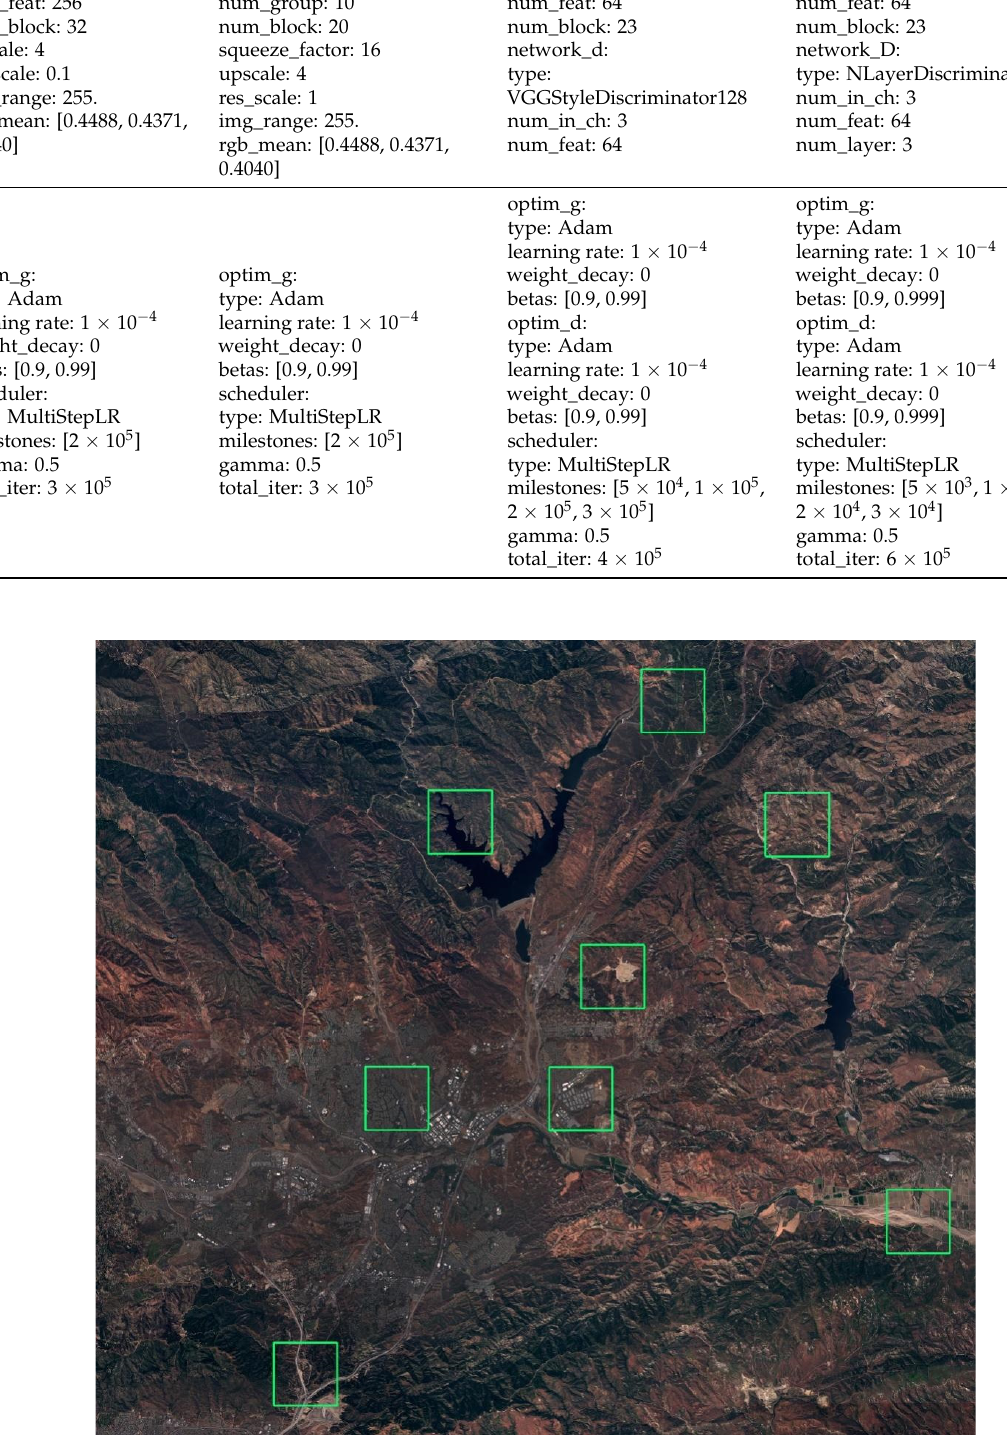
Figure 10. Ground map corresponding to sub-dataset “Rois1158_spring_106.”.